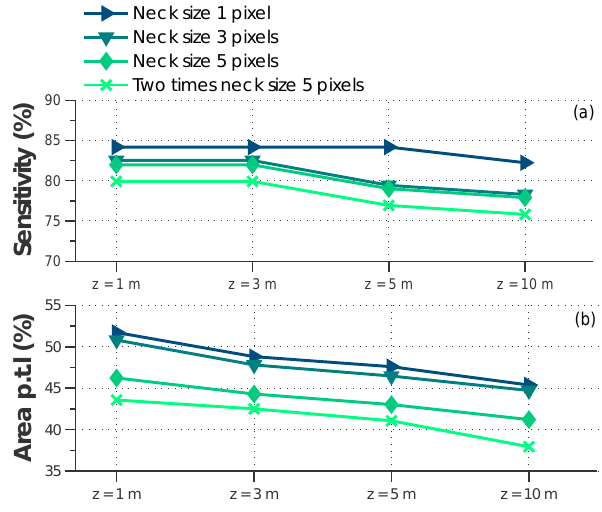
Figure 4. The sensitivity (a) and area prone to landslides (b) ob- tained by varying the elevation difference criterion. Results are shown for four pre-filtering options (i.e., neck size). The elevation difference criterion is given in meters